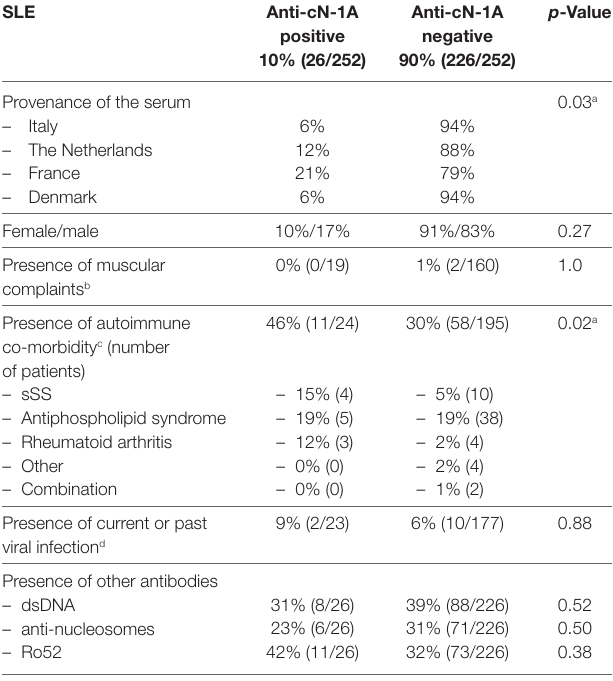
Table 2 | Clinico-demographic correlations: anti-cN-1A in systemic lupus erythematosus (SLE).